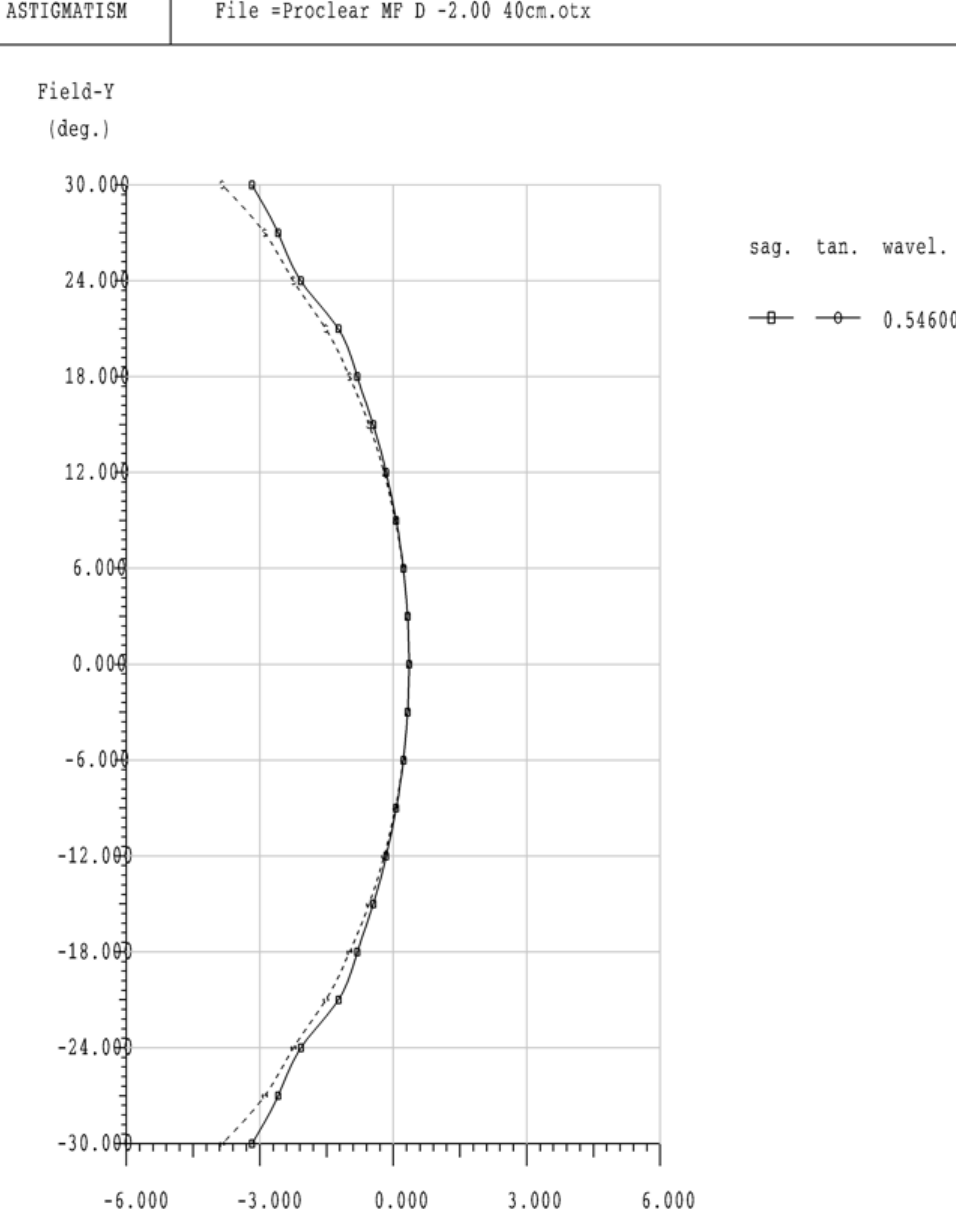
Figure 9. Simulated retinal image quality from the central up to 30° nasal and temporal. ( Top row ): Proclear monofocal. ( Bottom row ): Proclear multifocal. Viewing distance at infinity.